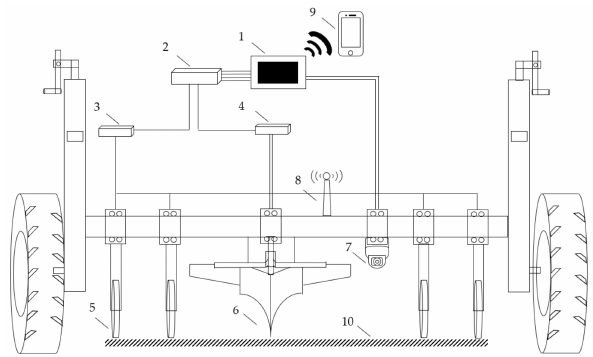
Figure 4. Detector structure diagram. 1 Industrial tablet computer; 2 Data acquisition card; 3 Circuit 1;